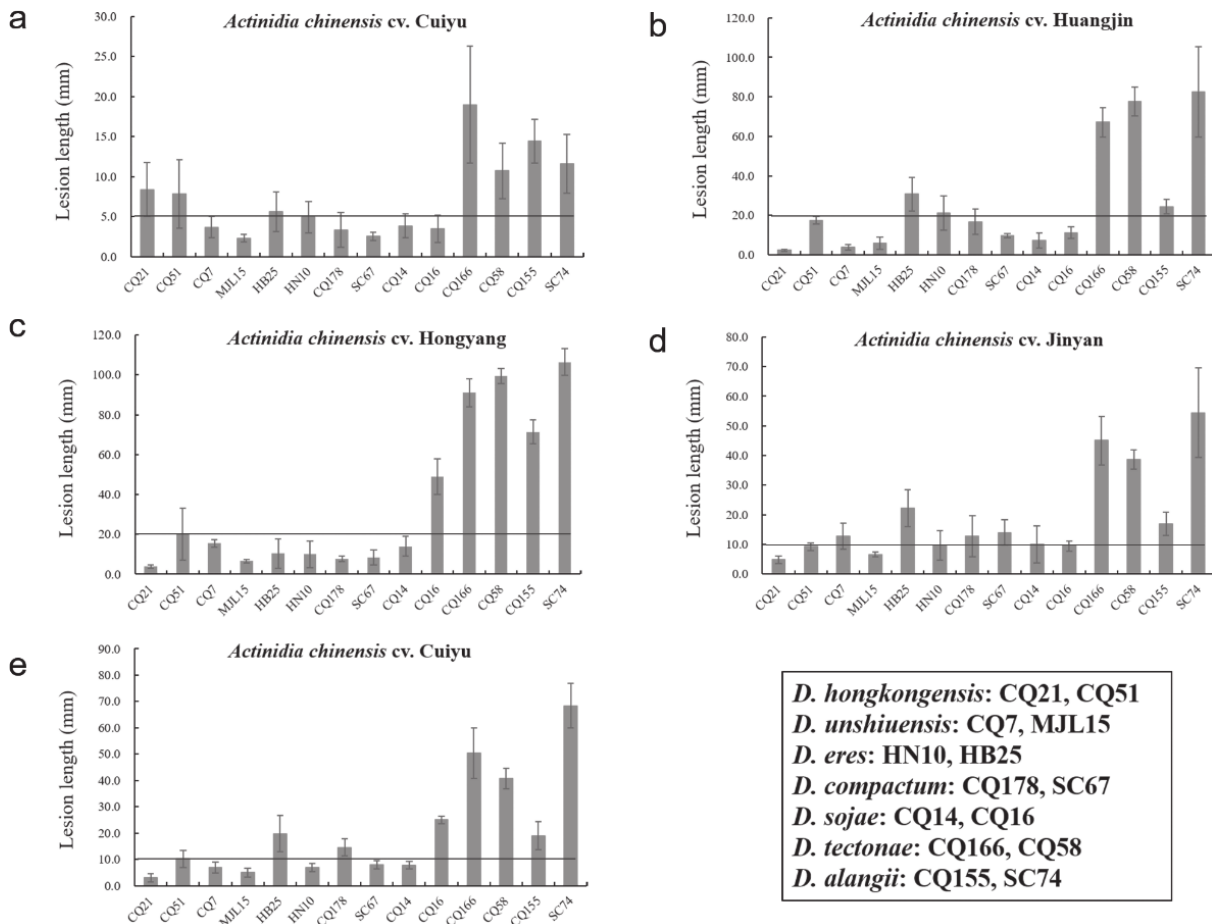
Figure 6. Mean lesion lengths on wounded kiwifruit leaves and shoots at 10 dpi with mycelium plugs of representative isolates of seven Diaporthe species. a, lesion length on wounded leaves of Actinidia chinensis ‘Cuiyu’. b to e, lesion lengths on the wounded kiwifruit shoots ( Actinidia chinensis ‘Huangjin’, Actinidia chinensis ‘Hongyang’, Actinidia chinensis ‘Jinyan’, or Actinidia chinensis